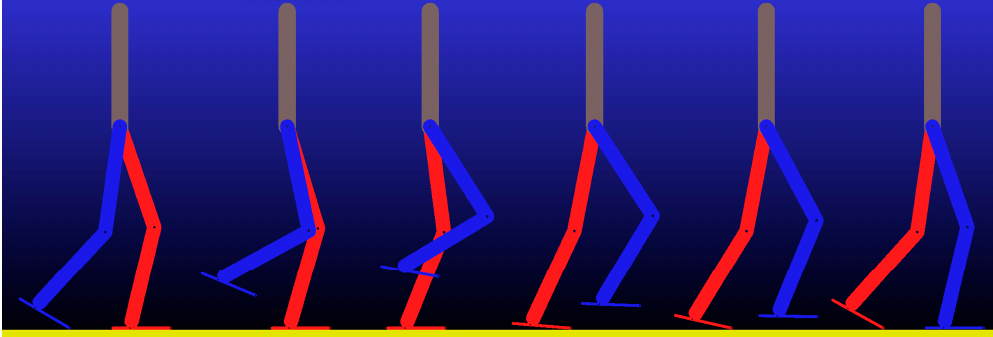
Figure 7. Snapshots of the simulated bipedal robotic walking gait in one cycle. Appl. Sci. 2017 , 7 , 499